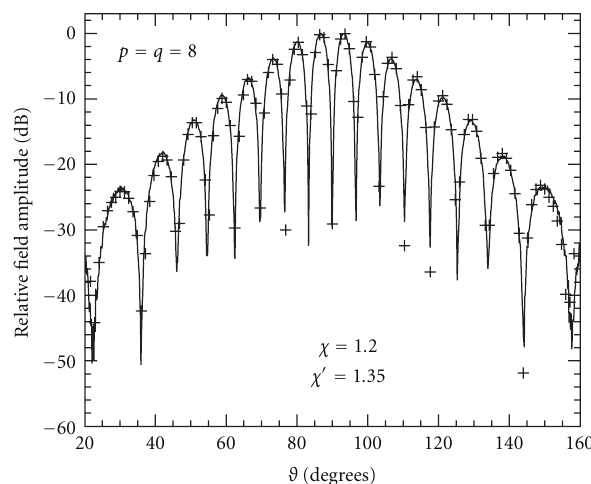
Figure 13: H-plane pattern. Solid line: obtained from NF data measured on the classical cylindrical grid. Crosses: reconstructed from NF data acquired via the nonredundant cylindrical scanning.